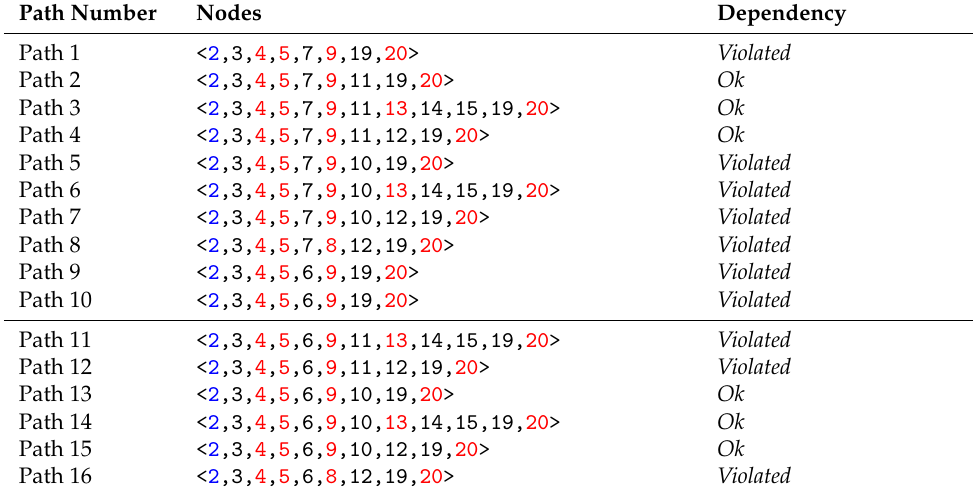
Table 4. All path(total 16) in the graph.